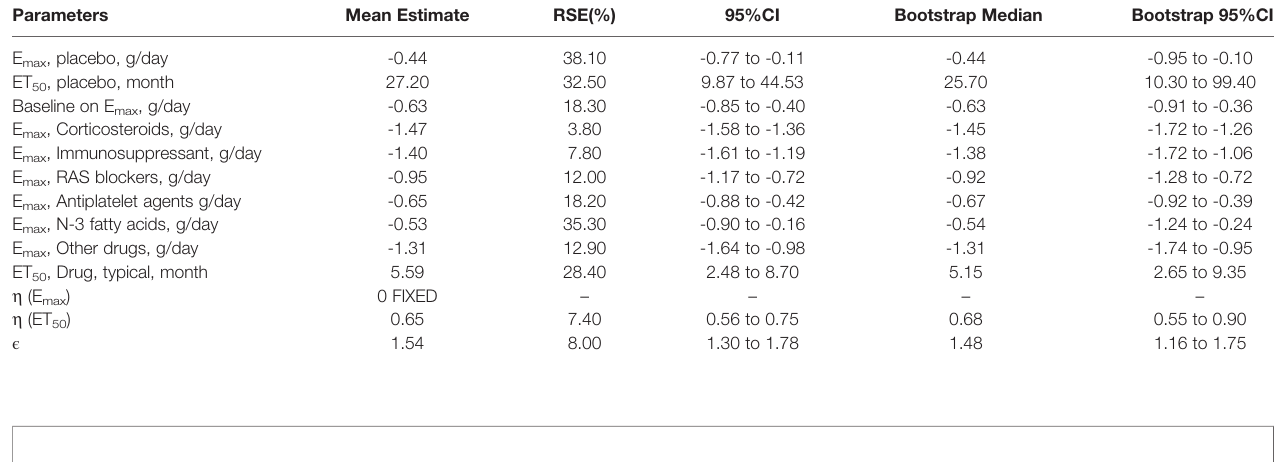
TABLE 2 | Estimated values of fi nal model parameters and Bootstrap resampling parameters.